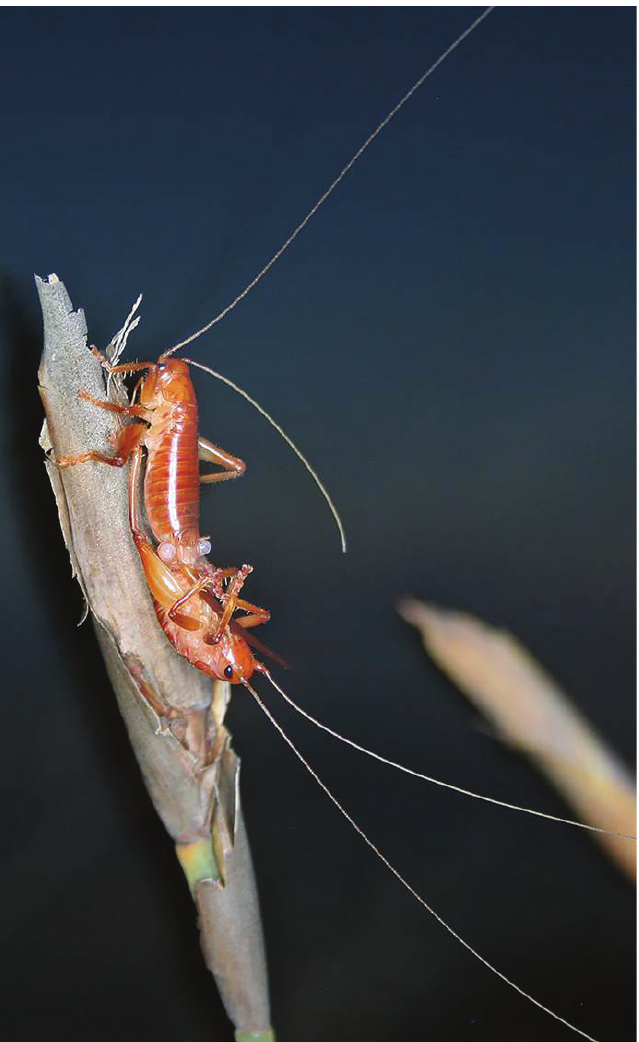
Fig. 3. Glomeremus sp. 3. A mating pair from the southwestern Cape Province, South Africa. The female is on top, the male be- low her. Spermatophores, produced by the male during copula- tion, and characteristic of Ensifera, are clearly visible. Body length about 15 mm. Photo by C. S. Bazelet.